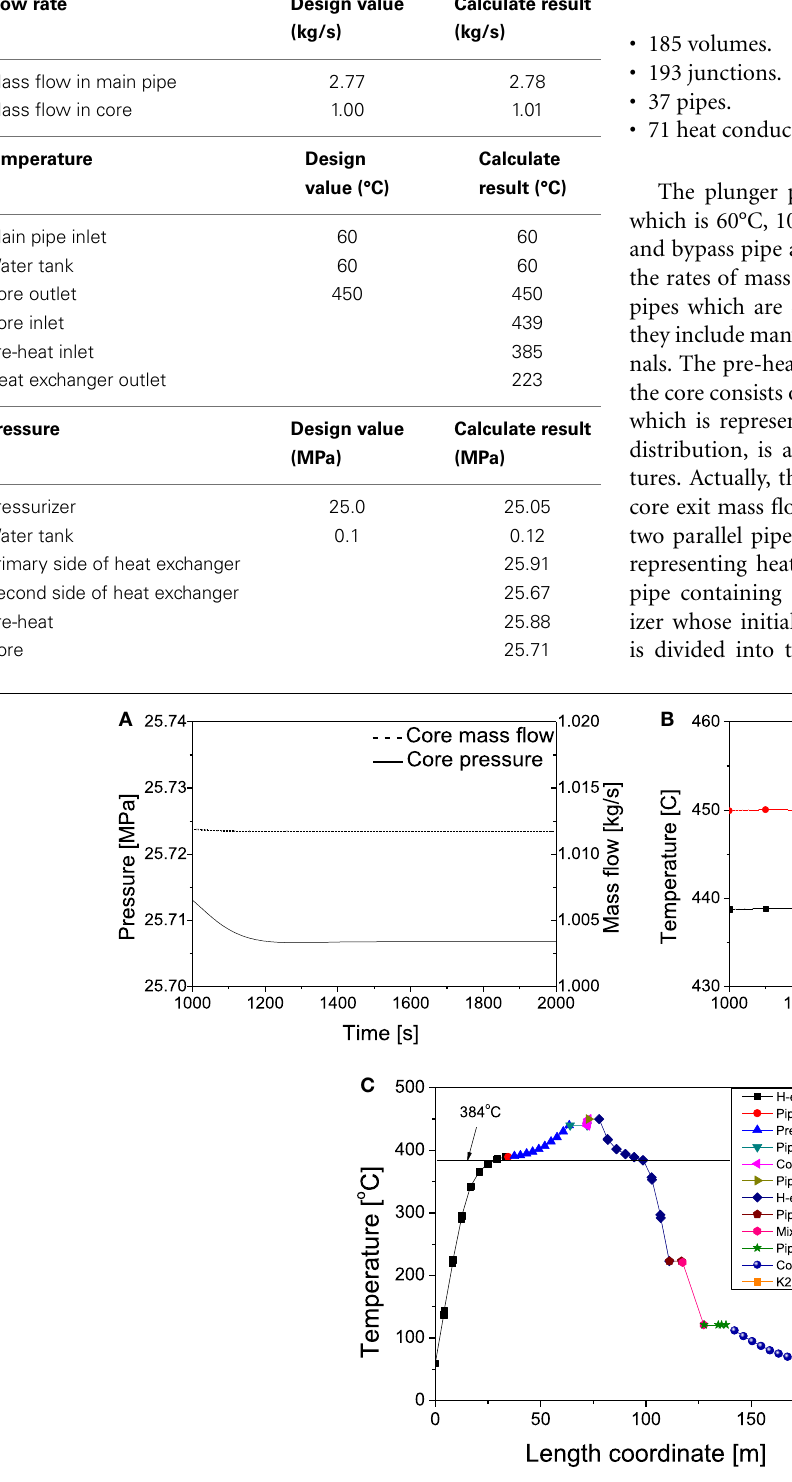
FIGURE 4 | Operation parameters and temperature distribution of the main test loop . (A) Mass flow and pressure in core. (B) Coolant temperature of core inlet and outlet. (C) Temperature distribution of the main test